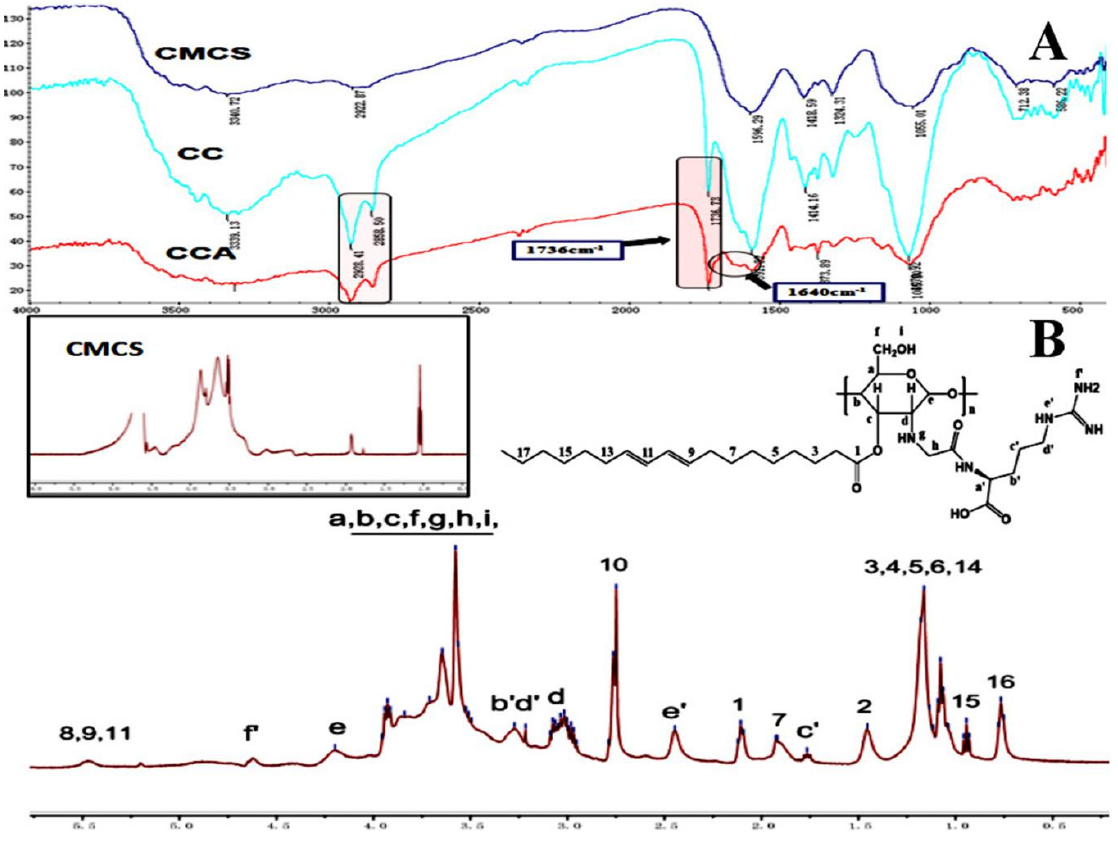
Figure 2. FTIR ( A ) and 1 H NMR ( B ) spectra of CLA-CMCS-Arg.